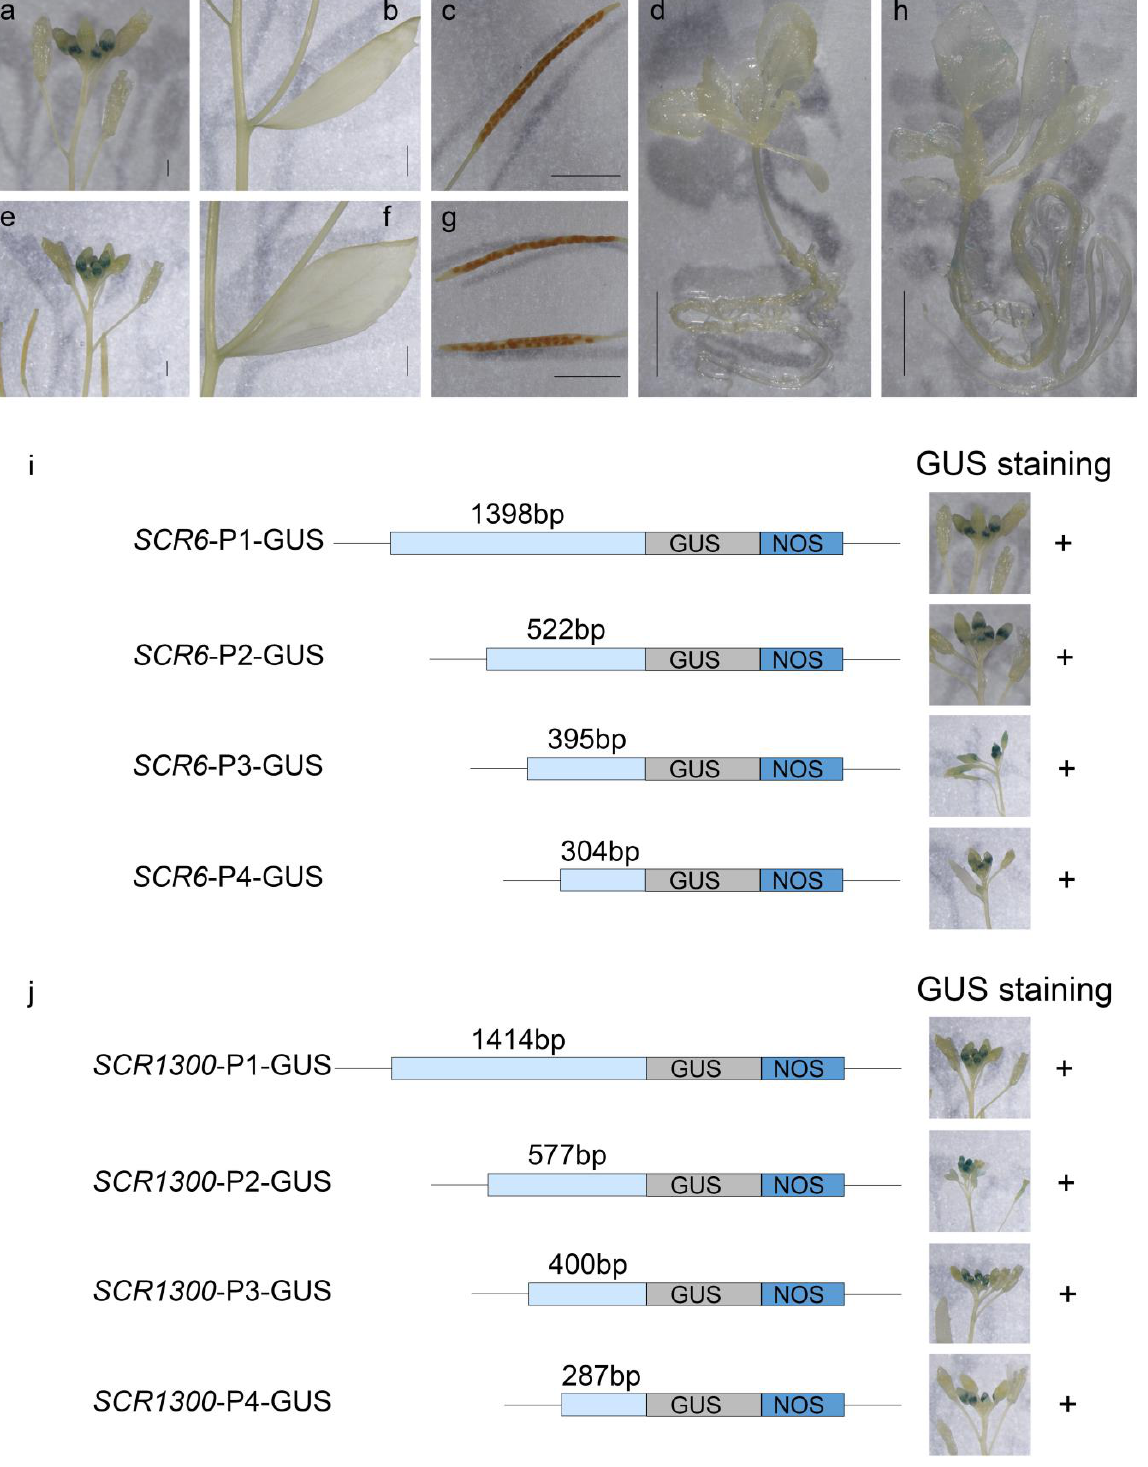
Figure 3. Comparison of the GUS staining of BnSCR-6 and BnSCR-1300 promoters in different Arabidopsis tissues. ( a – d ) are the GUS staining of BnSCR-6 in different parts of plants; ( e – h ) are the GUS staining of BnSCR-1300 in different parts of plants; ( a ), ( e ) are flower buds; ( b ), ( f ) are stems and leaves; ( c ), ( g ) are siliques; ( d ), ( h ) are the whole plant at the seedling stage; ( i ) is the GUS staining of different length of BnSCR-6 promoter in flower buds; ( j ) is the GUS staining of different lengths of BnSCR-1300 promoter in flower buds.